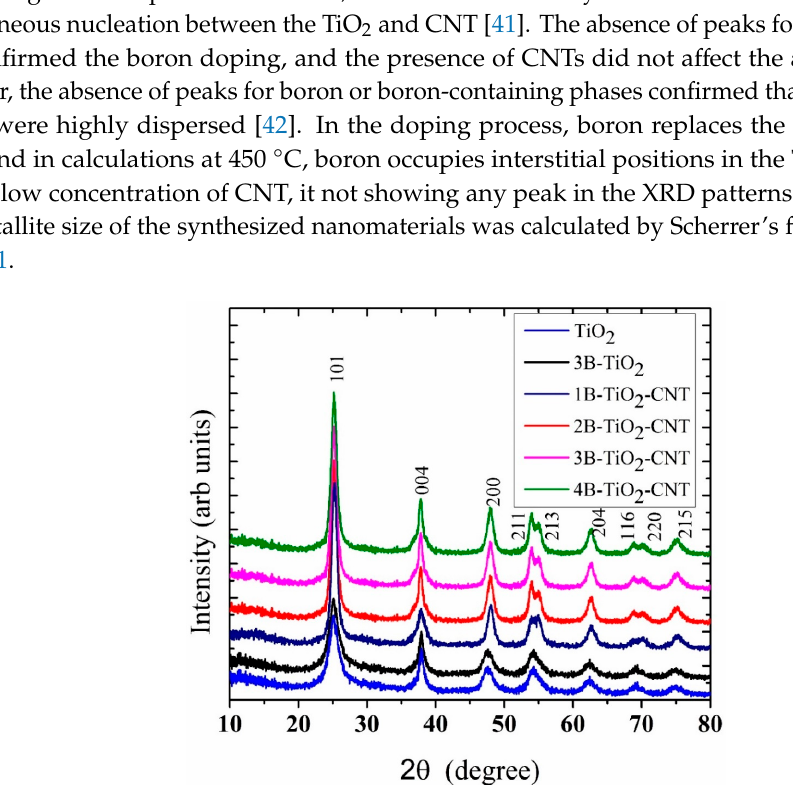
Table 1. Crystallite size and optical bandgap of synthesized nanomaterials.